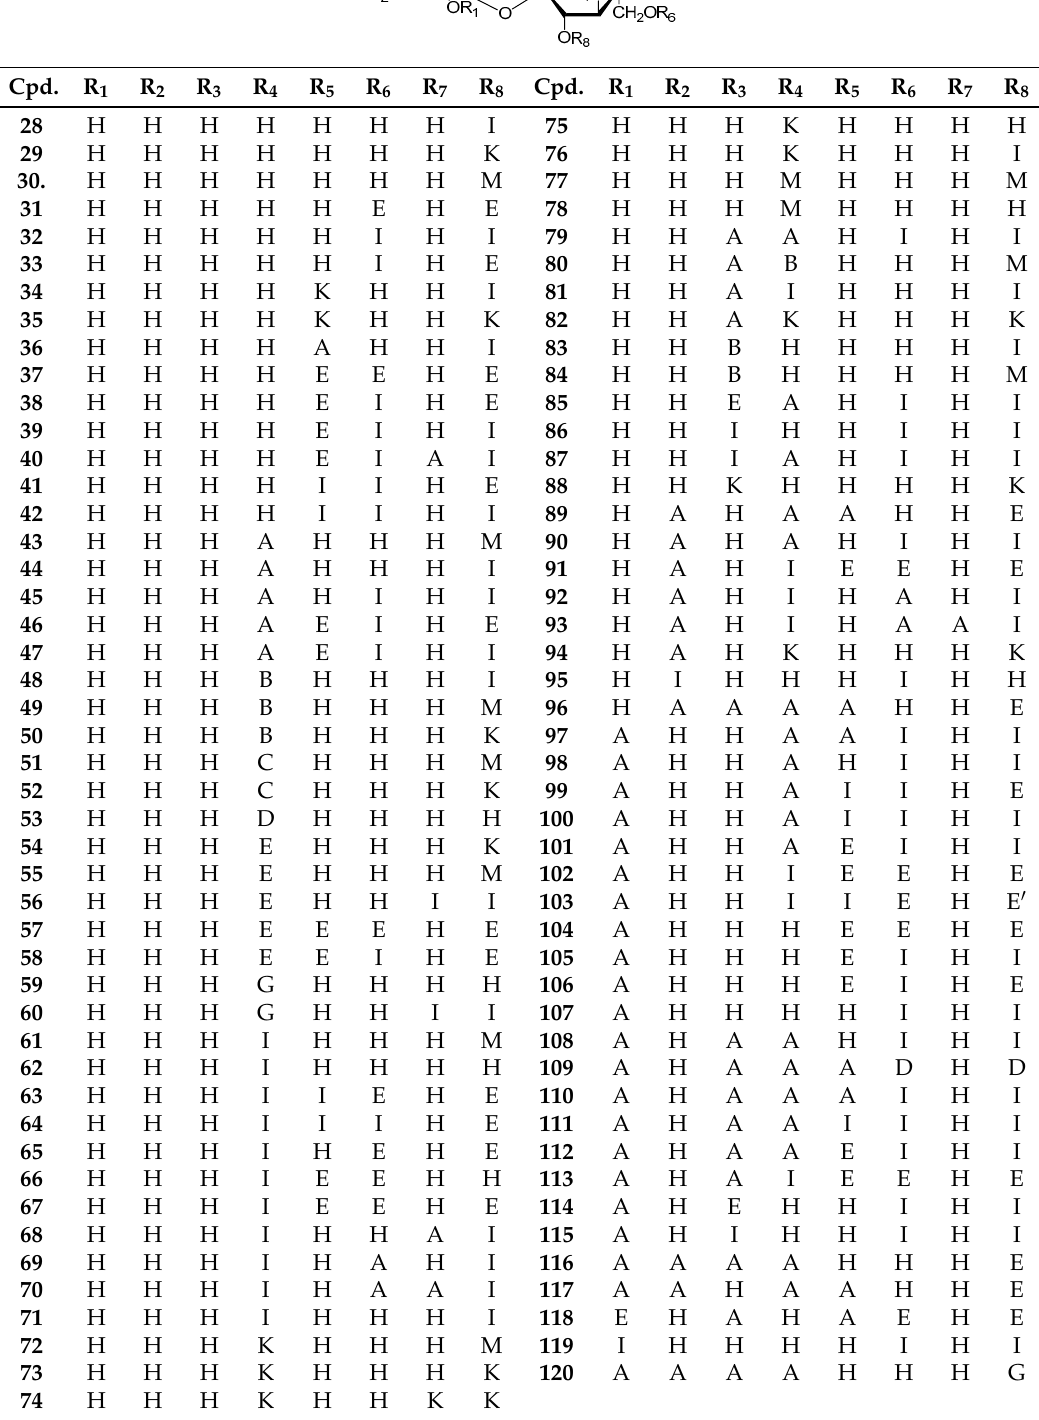
Figure 6. Structures of compounds 28 – 120 .